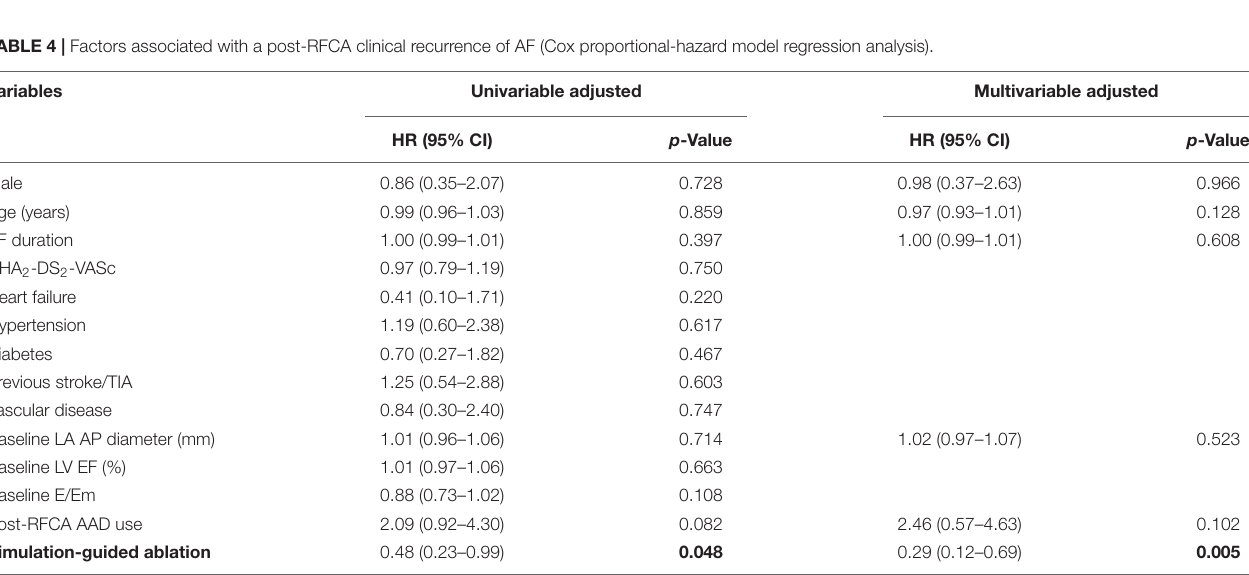
FIGURE 3 | Kaplan–Meier curves according to patients with AAD usage. (A) Overall patients. (B) Patients with maintaining AAD use after catheter ablation. (C) Patients without maintaining AAD use after catheter ablation. AAD, antiarrhythmic drug.